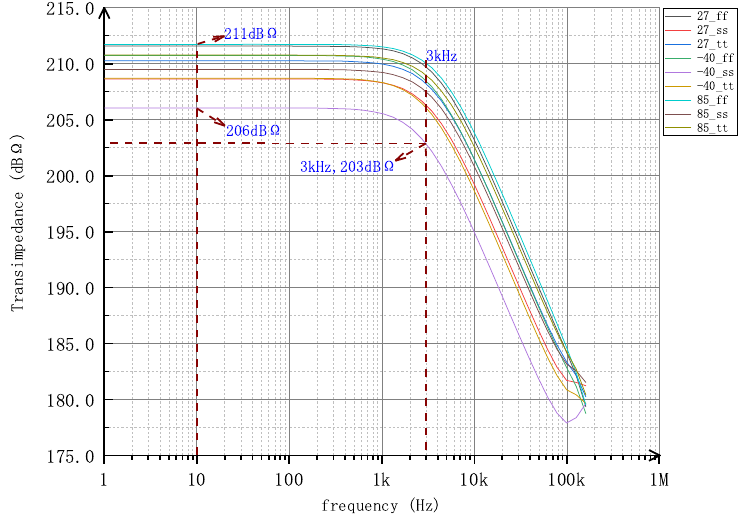
Figure 13. Frequency response of the complete system.